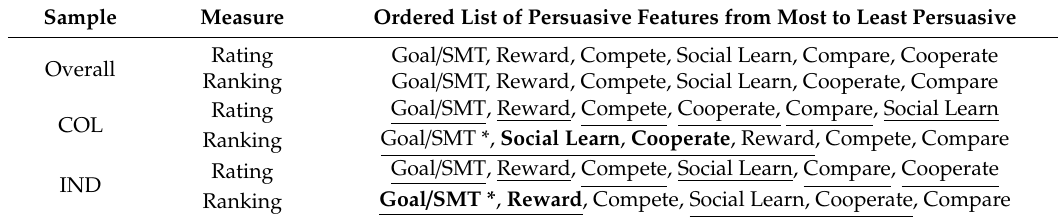
Table 7. Persuasion profiles based on the perceived persuasiveness of strategies for the overall and culture-specific samples; COL = Collectivist culture, IND = Individualist culture; “the underlined” indicates where IND and COL significantly di ff er ( p < 0.05) with respect to each measure, with the bolder feature indicating higher users’ susceptibility; “*” indicates marginal significant di ff erence ( p = 0.085) between the concerned pair of